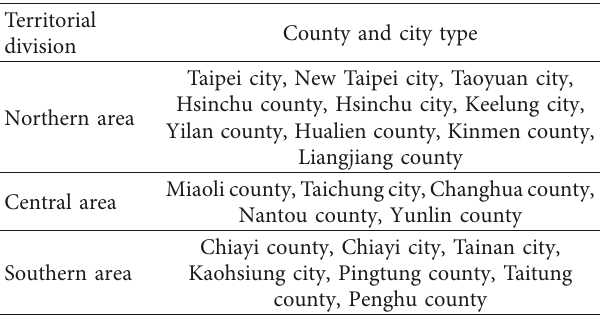
Table 2: Territorial division of northern, central, and southern areas in